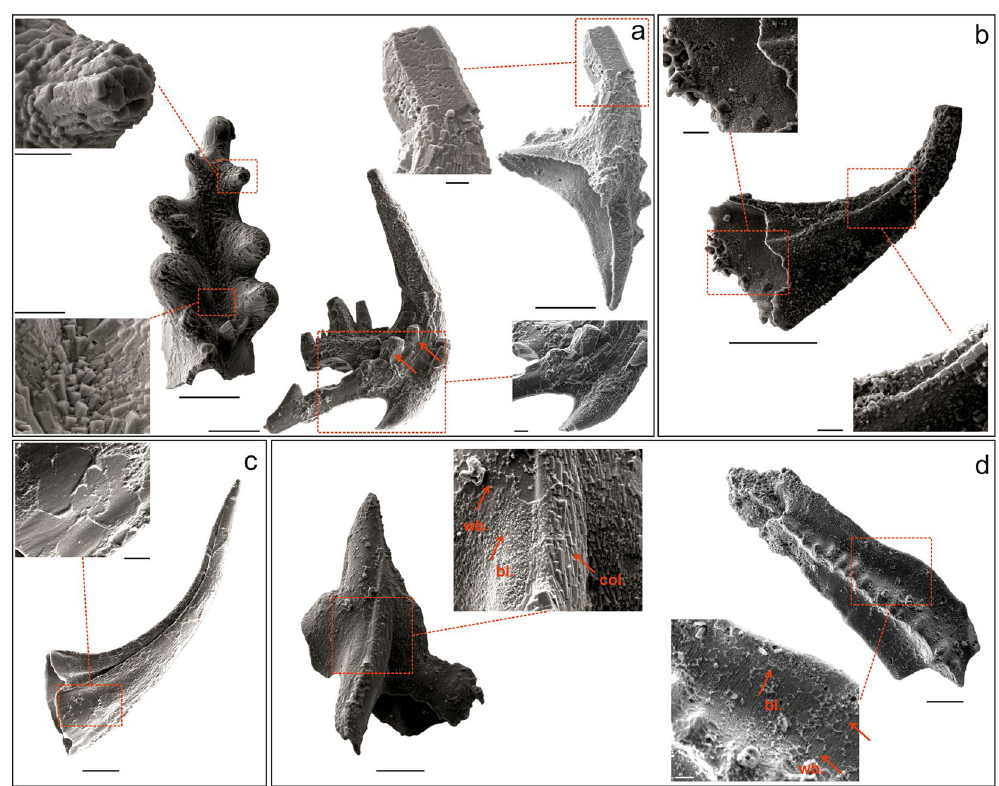
Figure 2. Crystal microtextures. ( a ) ESEM images of large columnar crystal microtexture in: ( a , left) Icriodella sp., Pa element; specimen IPUM 28984, sample W-BK(B)-2006. Note how crystals are arranged to form rosettes to replace the original denticle (top enlargement) or configured as a sort of fan (bottom enlargement). ( a , centre) Amorphognathus sp., Sd element; specimen IPUM 28985, sample W-BK(C)-2006. Red arrows indicate crystals that have replaced the original process denticles. ( a , right) Amorphognathus sp., Pb element; specimen IPUM 28986, sample W-BK(C)-2006. The main denticle (cusp) has been fully replaced by a prismatic form. ( b ) ESEM images of blocky crystal microtexture in Scabbardella altipes ; specimen IPUM 28987, sample W-BK(C)-2006. ( c ) ESEM images of web-like crystal microtexture in Scabbardella altipes ; specimen IPUM 28988, sample W-BK(C)-2006. ( d ) ESEM images showing simultaneous presence of: ( d , left) large columnar (col.), blocky (bl.) and web-like (wb.) crystal microtexture on the surface of Sagittodontina robusta , Pa element; specimen IPUM 28989, sample W1-2006; ( d , right) blocky (bl.) and web-like (wb.) crystal microtexture on the surface of Amorphognathus sp., Pa element; specimen IPUM 28990, sample W1-2006. Scale bars correspond to 100 μ m (conodont element) and 20 μ m